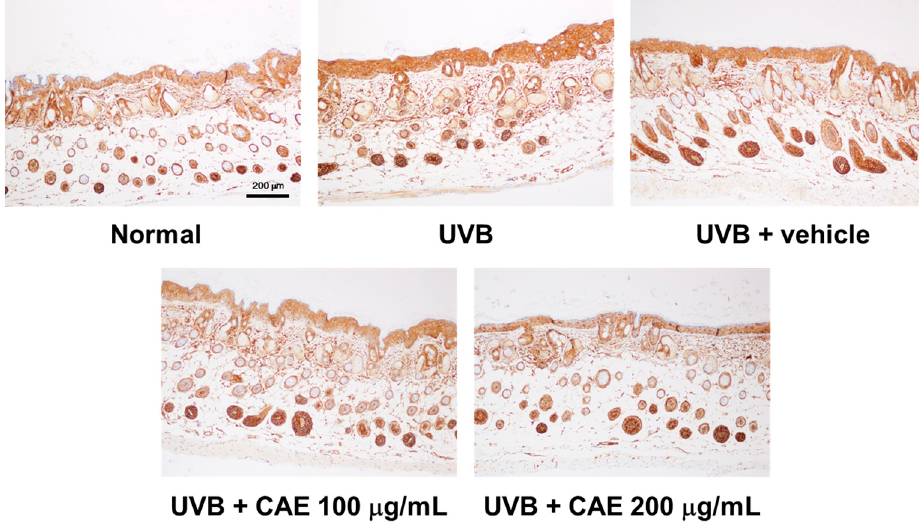
Figure 20. Immunohistological staining for NF- κ B in the hairless mouse skin after UVB exposure and CAE treatment.